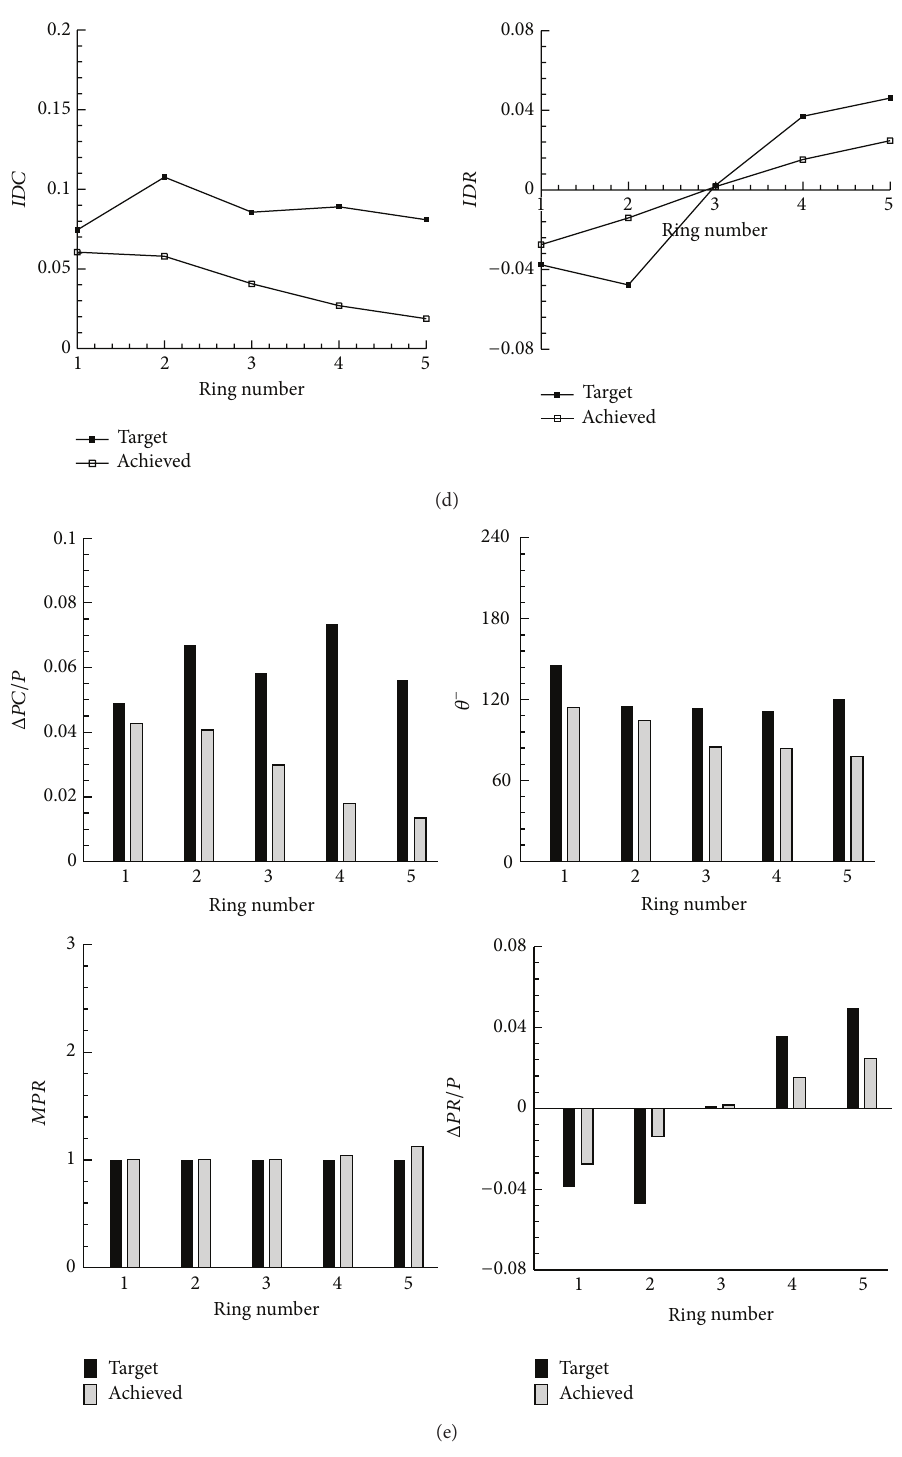
Figure 12: Contours of (a) target and (b) achieved total pressure loss distributions, (c) ring-wise total pressure loss distribution, (d) circumferential ( IDC ) and radial ( IDR ) distortion elements and (e) circumferential distortion intensity ( Δ PC / P ), circumferential extent ( 𝜃 − ), multiple-per-rev ( MPR ), and radial distortion intensity ( Δ PR / P